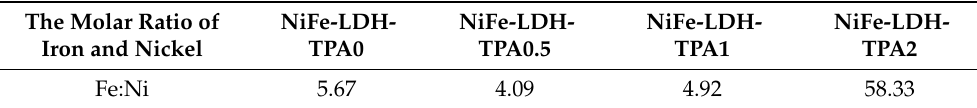
Table 1. ICP-OES results.